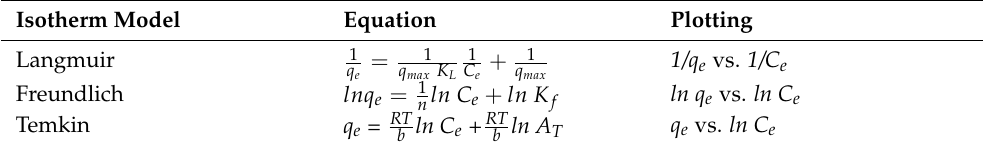
Table 1. List of the adsorption isotherm models used and their expressions. Isotherm